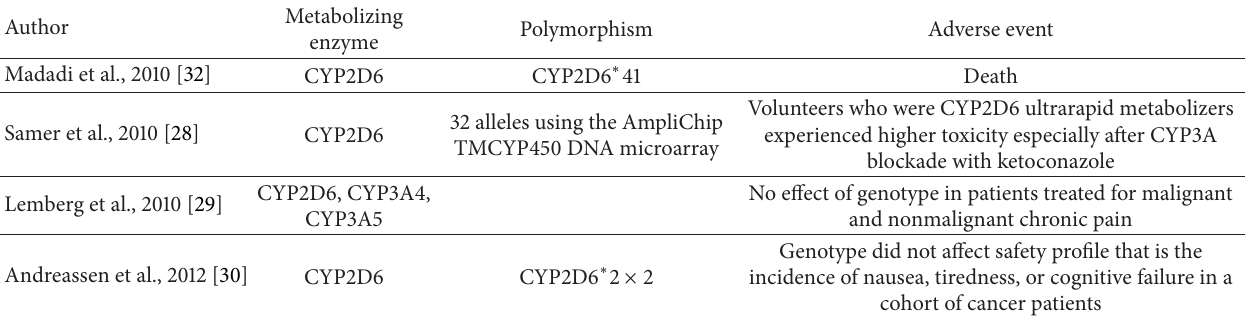
Table 2: Case reports providing evidence on the impact of polymorphisms of metabolizing enzymes on the safety of hydrocodone or